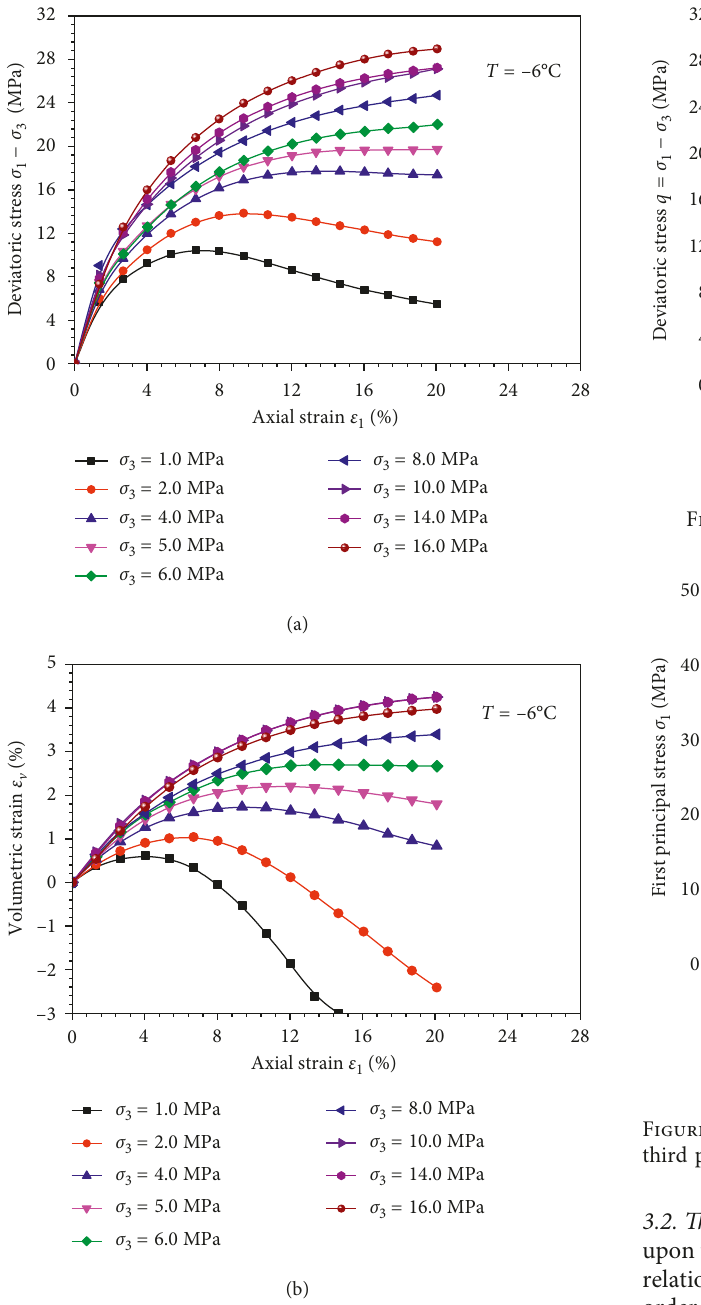
Figure 1: The curves of deviatoric stress-axial strain (a) and vol- umetric strain (b) of frozen sandy soils (Lai et al. [17]).